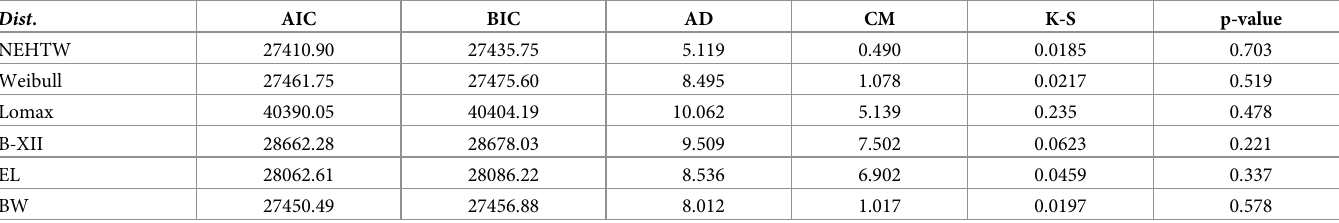
Table 10. Analytical measures of the NEHTW distribution and other competitors. Dist .